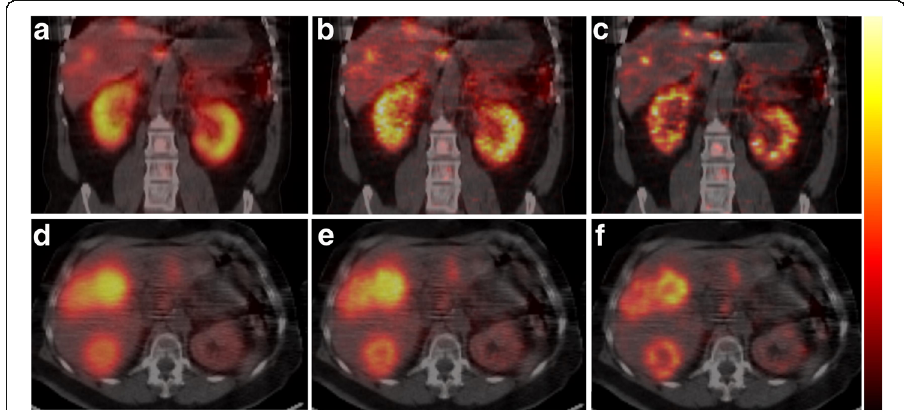
Fig. 5 SPECT reconstructions of the 177 Lu distribution in two patients treated with 177 Lu-DOTATATE. Panels a , d show the post-filtered AC-OSEM reconstructed SPECT images that are used in the clinical protocol, while panels b , e show SPECT images reconstructed with unfiltered AC-OSEM, and panels c , f show SPECT images reconstructed with SARec-OSEM. In the Monte Carlo-based reconstruction with SARec, an increased number of tumors and an improved visualization of the heterogeneous activity distribution in the kidney were observed ( c ), which become more evident when a post-filter is applied (data not shown). Also, in the tumor tissue, the improved heterogeneous activity distributions were more easily observed with SARec OSEM compared with AC-OSEM, an example is the marked uptake differences between the tumor border and tumor center ( f versus d and e